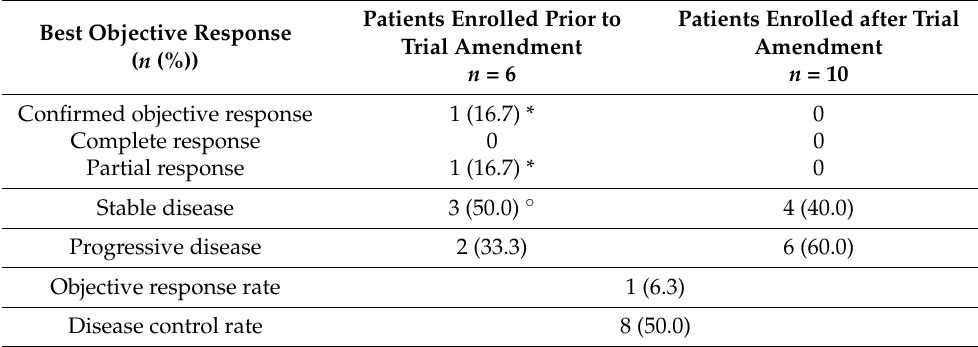
Table 3. Best objective response in patients enrolled prior to the trial amendment, and in patients enrolled after the trial amendment and who were part of the first stage of the study.